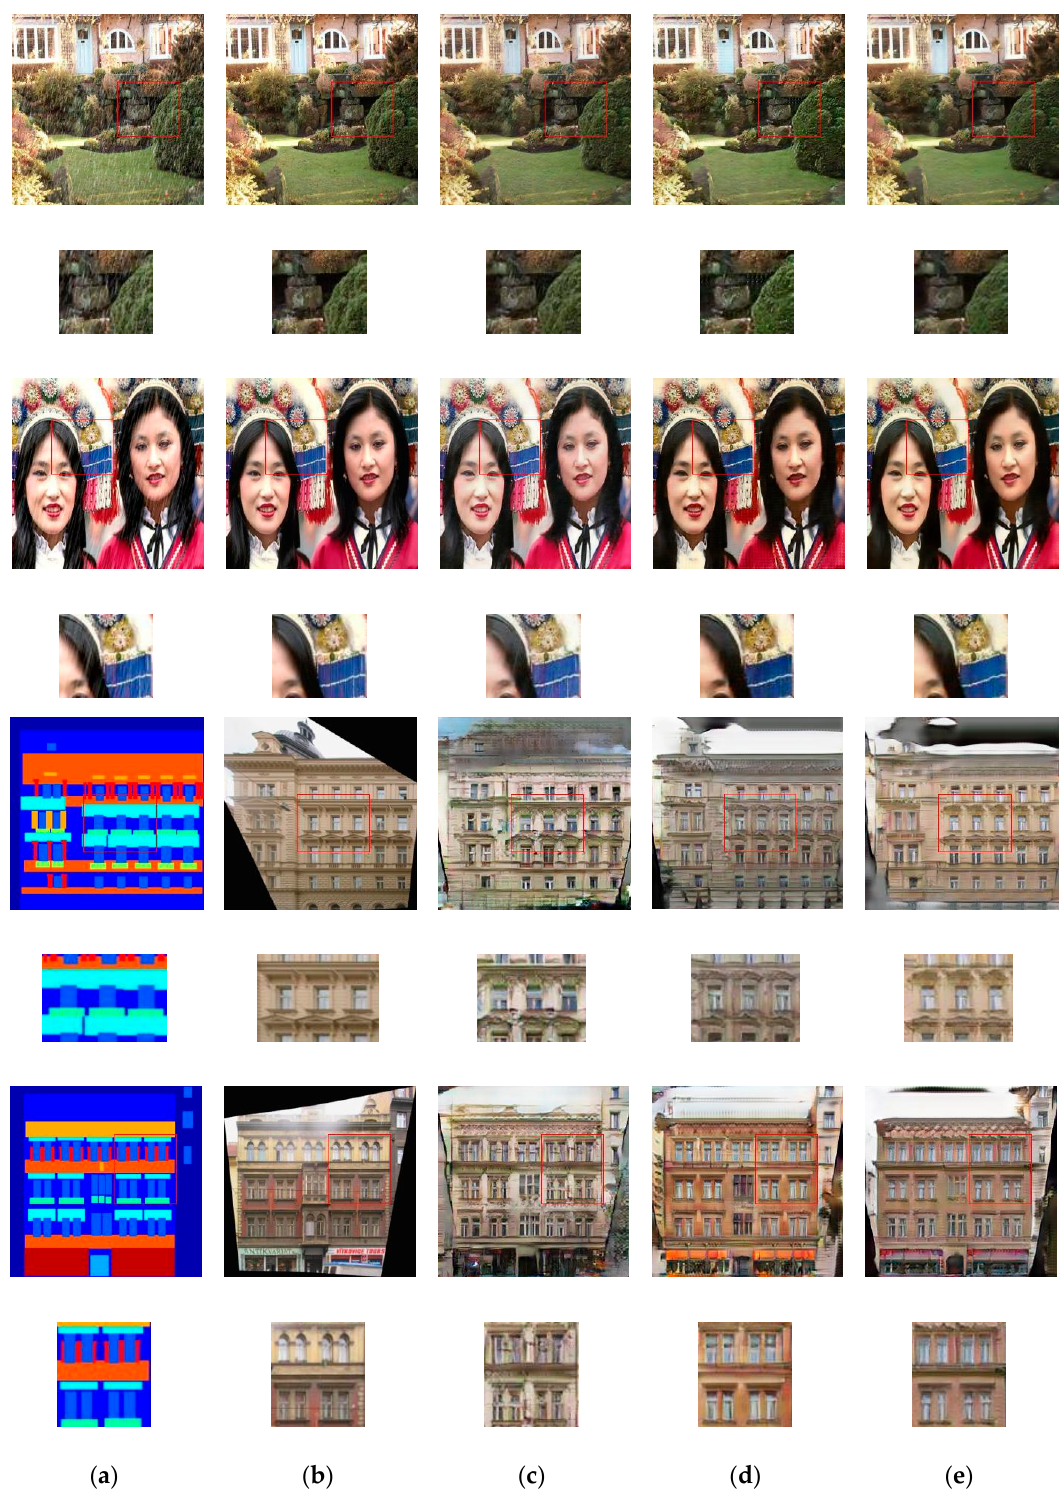
Figure 6. Sample results in the first four rows of rainy to de-raining images and last four rows of labels to architectural photos. For good visual comparison, the smaller images below the test images represent specific regions-of-interest. ( a ) input images, ( b ) targeted photos, ( c ) U-Net with skip-connections, ( d ) Encoder-Decoder and ( e ) IP-RAN.